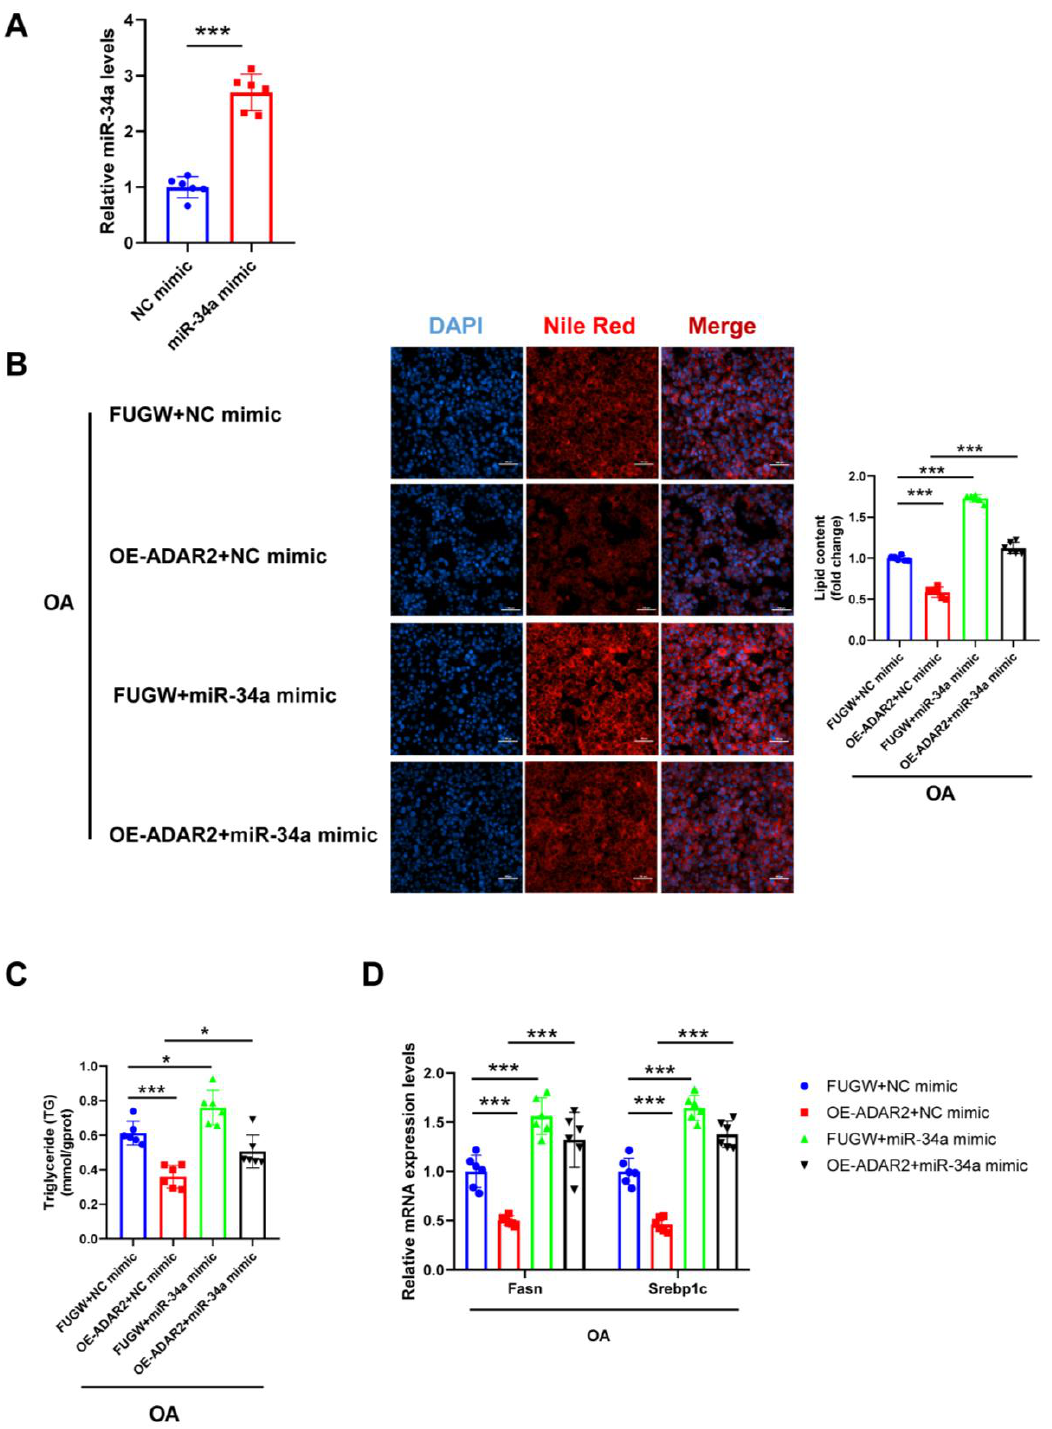
Figure 6. miR-34a blocks the inhibitory effect of ADAR2 on lipogenesis in hepatocytes. ( A ) The expression levels of miR-34a relative to U6 were analyzed by qRT-PCR after transfection with miR-34a mimic in HepG2 cells. ( B ) The lipid content of HepG2 cells was determined by Nile Red staining. ( C ) The TG levels of HepG2 cells. ( D ) The mRNA levels of lipogenesis-related genes (Fasn and Srebp1c) relative to GAPDH were analyzed by qRT-PCR. * p < 0.05, *** p < 0.001; n = 6. OE, overexpression; OA, oleic acid; TG, triglyceride; ADAR2, adenosine deaminases acting on RNA 2; Fasn, fatty acid synthase; Srebp1c, sterol regulatory element binding protein-1c. Scale bar = 100 μ m.